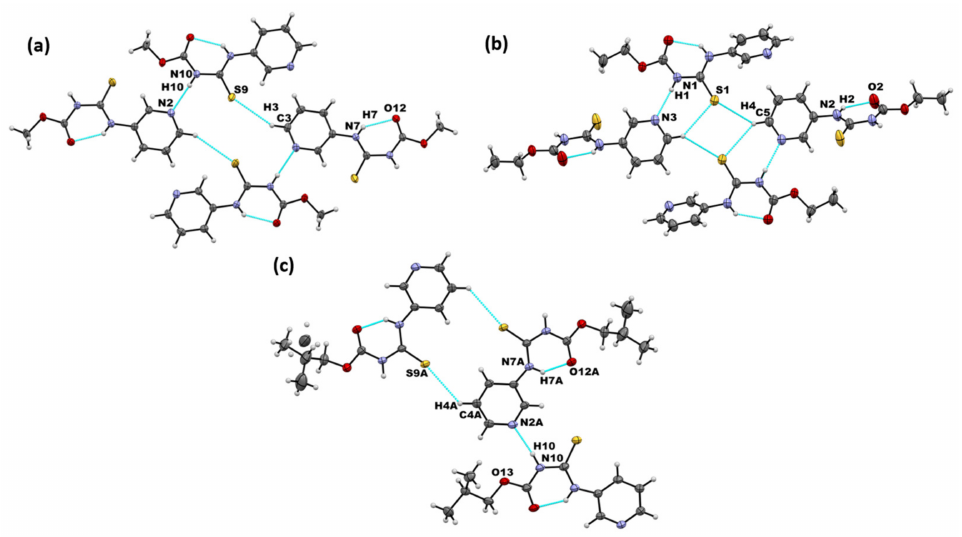
Figure 2. Primary non-covalent interactions (in blue) in the crystal structures of ( a ) A1 , ( b ) A2 , and ( c ) A3